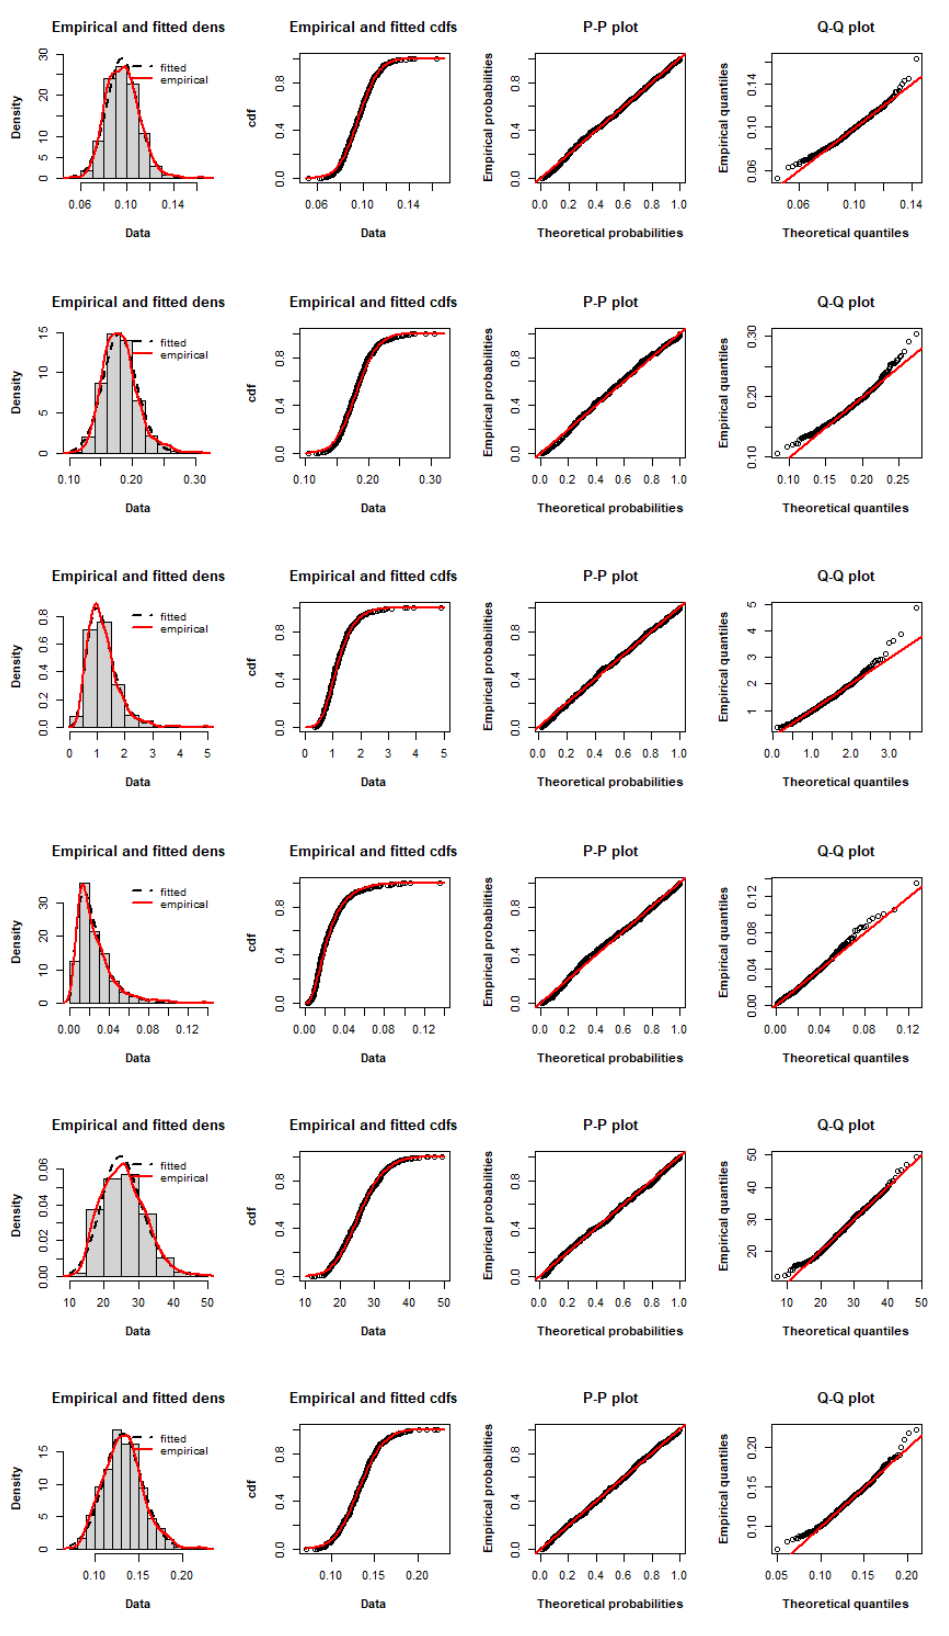
Figure 6. Empirical densities, empirical cdfs, P-P plots and Q-Q plots of the fitted MPoW distribution to the V7, V11, V14, V18, V24 and V27